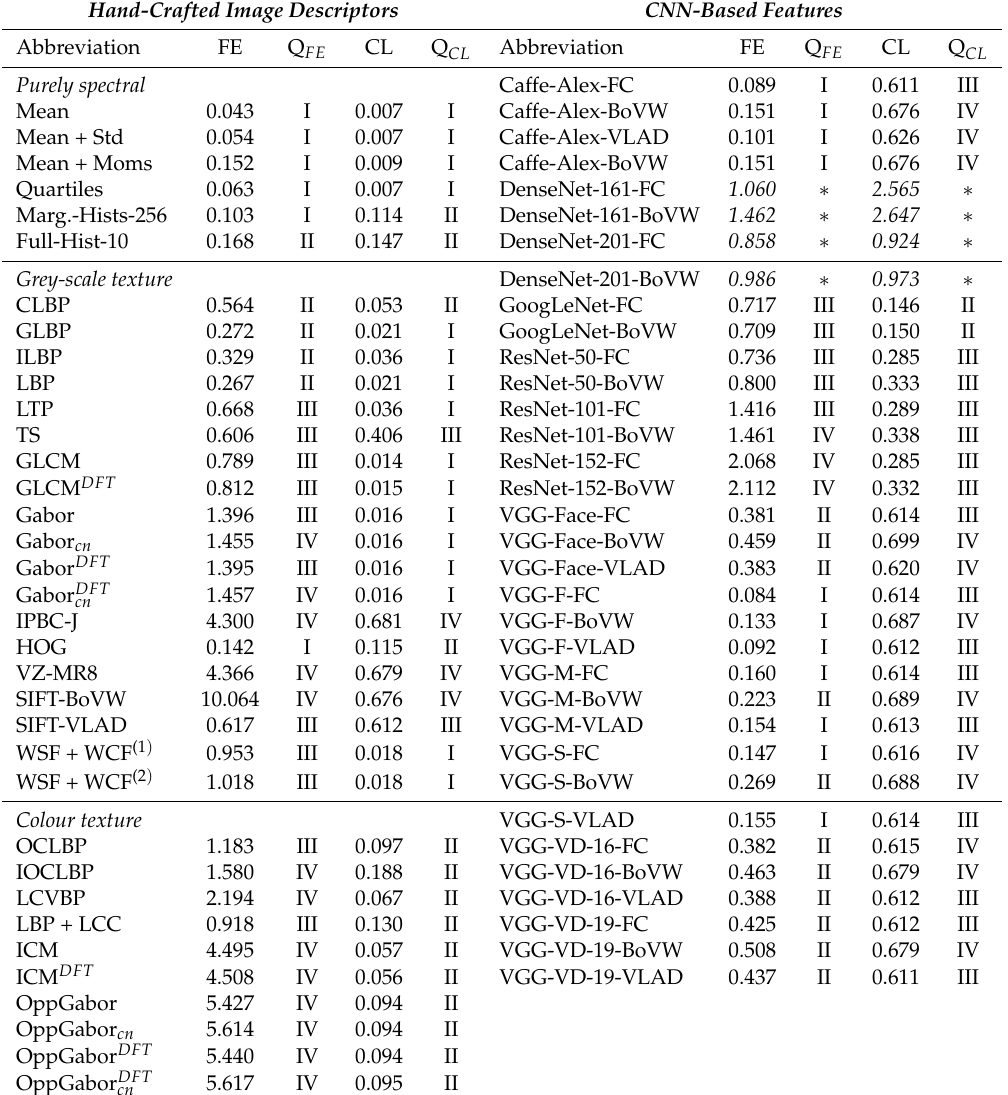
Table 17. Computational demand: FE = average Feature Extraction time per image, CL = average Classification time per problem; Q FE and Q CL are the corresponding quartiles. Values are in seconds. Note: features’ extraction and classification from the DenseNet-161 and DenseNet-201 models were carried out on a machine different from the one used for all the other descriptors. Consequently, computing times for DenseNets are not directly comparable to those of the other